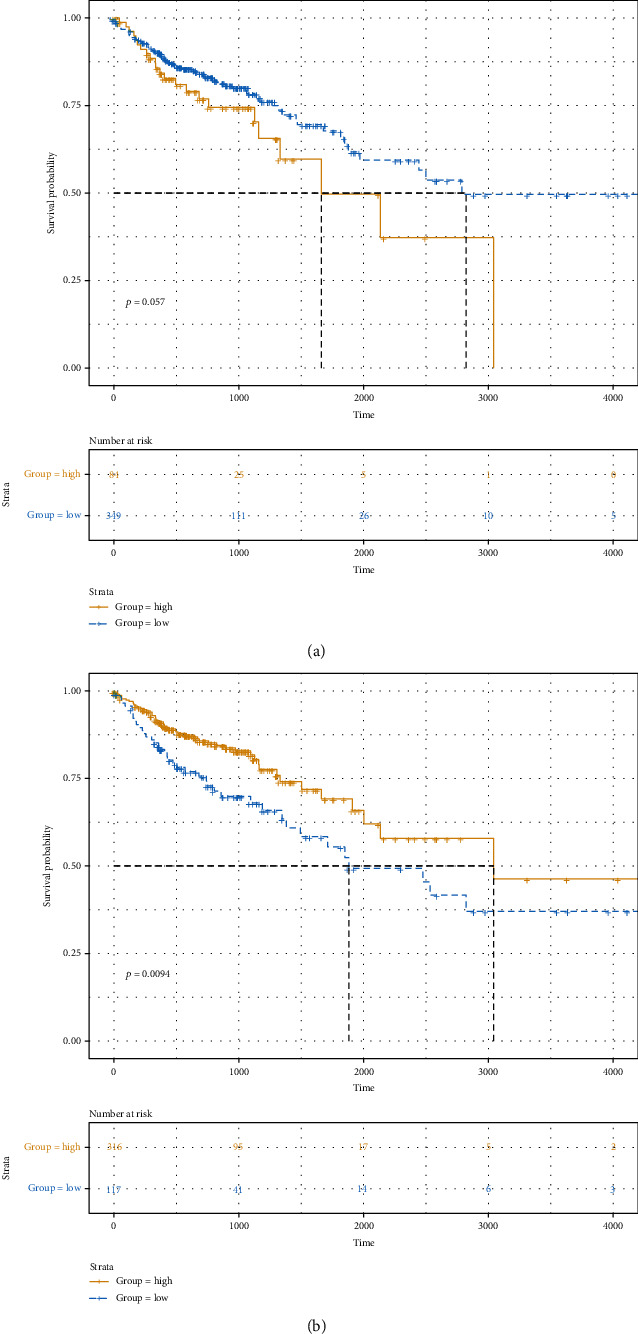
The correlation between stromal/immune scores and CRC patients' survival outcomes. (a) Stromal score. (b) Immune score. The x-axis suggests overall survival time and y-axis represents survival probability.